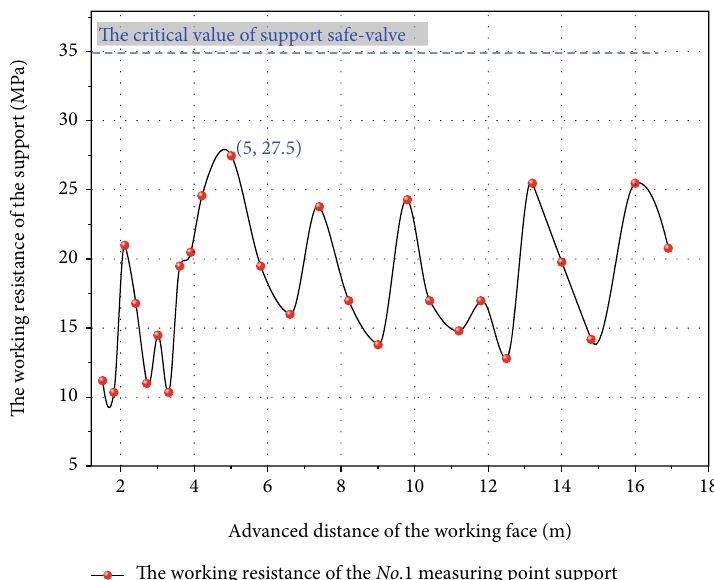
Figure 6: Working resistance of three hydraulic supports during the initial weighting of the immediate roof. (a) The working resistance of the No.3 measuring point (uncut side) support. (b) The working resistance of the No.2 measuring point (middle area) support. (c) The working resistance of the No.1 measuring point (roof cutting)